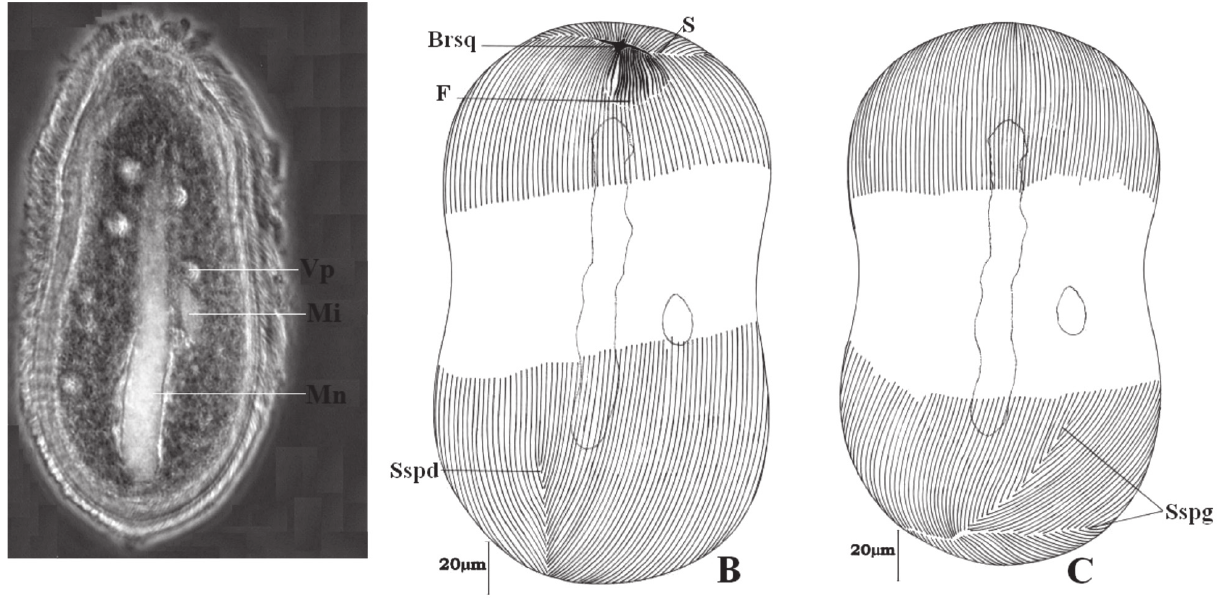
Figure 2. – Paracoelophrya falcifera n. sp.